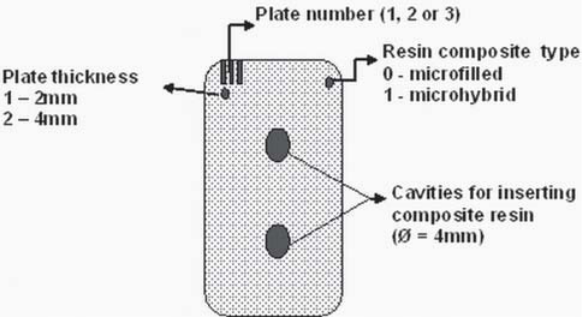
FIGURE 1- Acrylic plate with the cavities for inserting the composed resins and showing plate